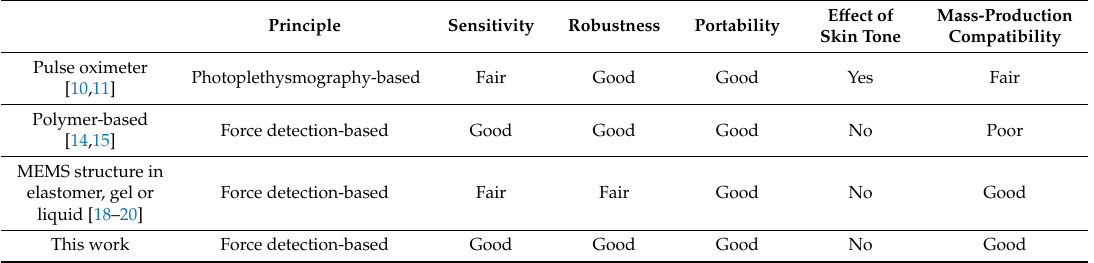
Table 1. Comparison of the proposed sensor with other devices proposed in previous